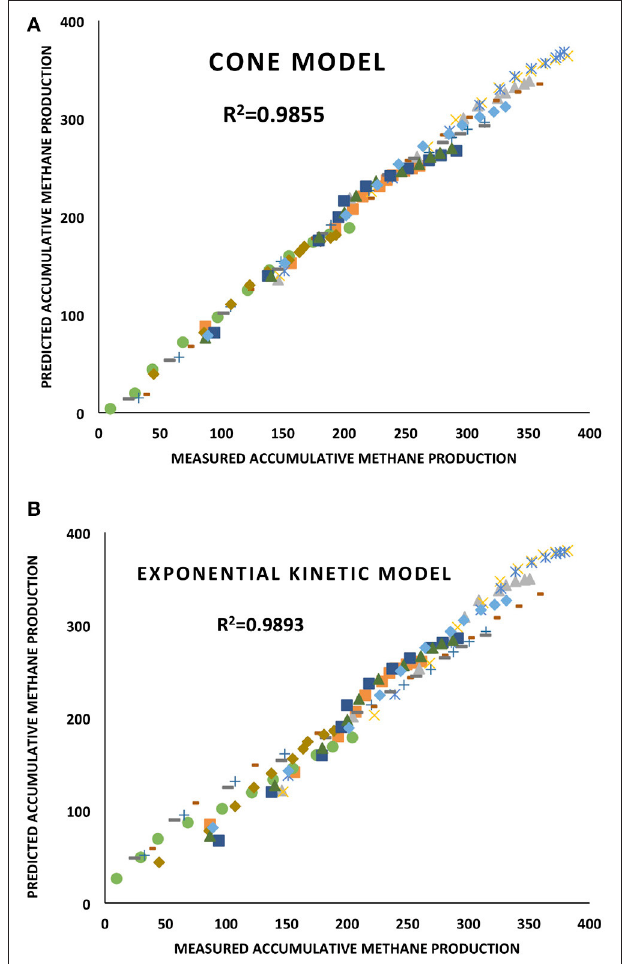
FIGURE 15 | Predicted methane yield against measured values for (A) cone model, (B) exponential kinetic model.